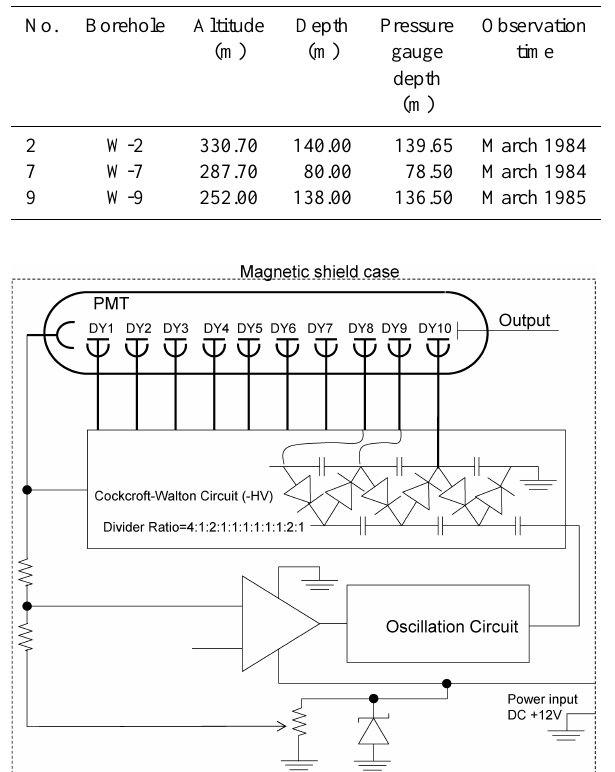
Table 2. Pulse output from the